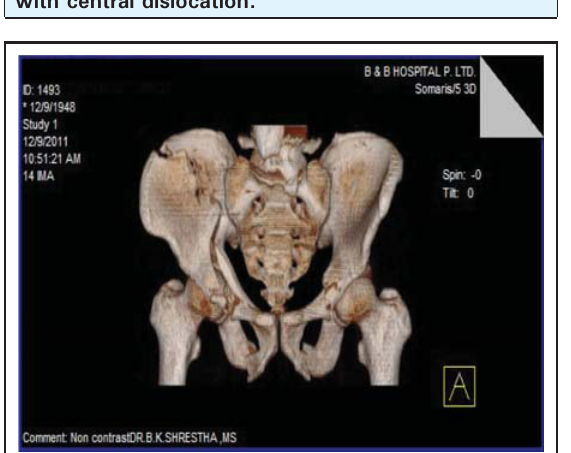
Figure 4. 3-D image of the pelvic ring fracture extend- ing to the acetabulum on right side.